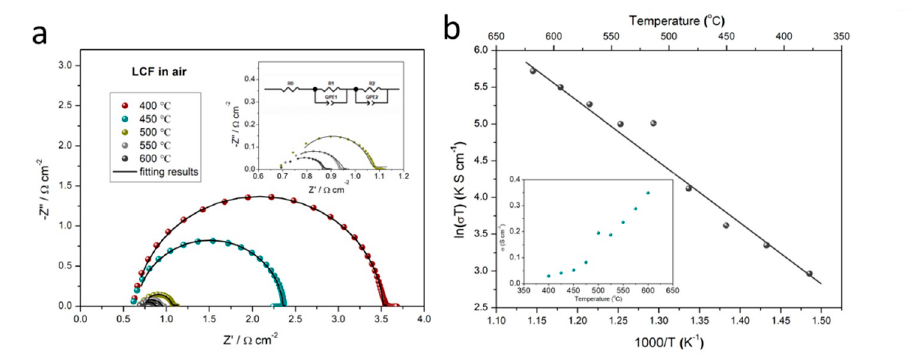
Figure 3. ( a ) Selected EIS patterns for LCF sample measured at various temperatures (400–600 °C in an interval of 25 °C) in air (insert images are the employed equivalent circuit for fitting and the enlarged EIS measured at 550, 550, and 600 °C). ( b ) Temperature-dependence Arrhenius plot in terms of ln( σ T) versus 1/T and the corresponding conductivities are plotted in the insert versus temperatures.